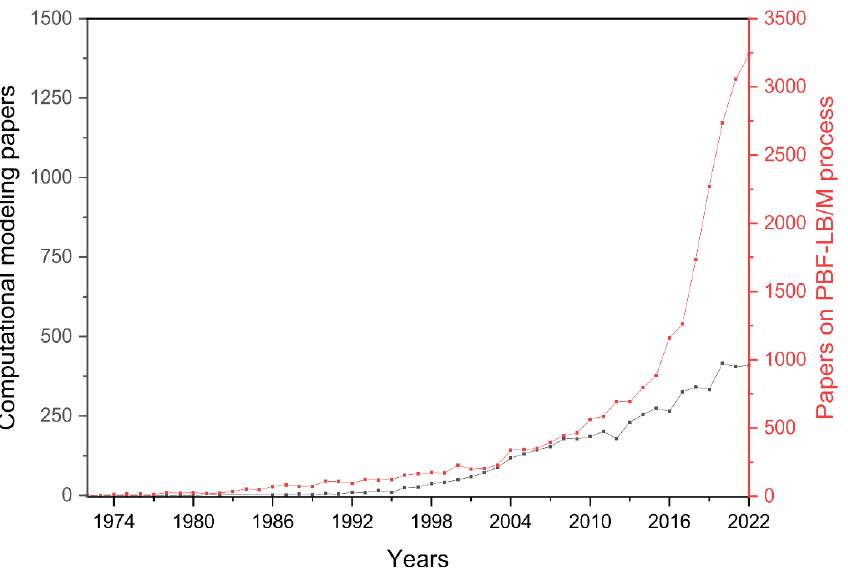
Figure 2. Literature trends on the development of computational models for the novel composition design related to the growth of the PBF-LB/M process, according to the Scopus